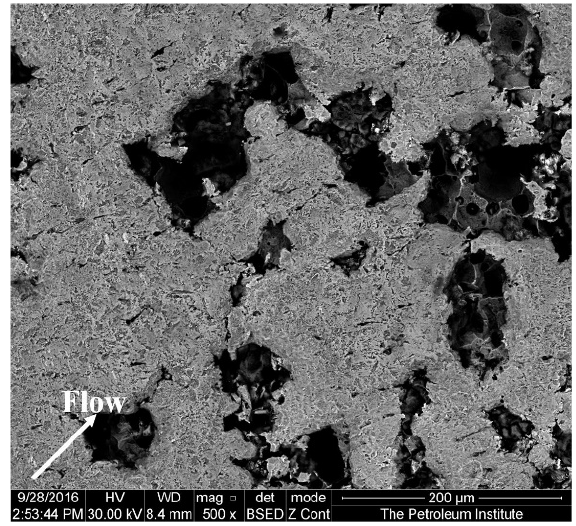
Figure 6. Surface of the specimen 2 mm away from the center after 4 h test at 20 m/s and 600 mg/L.